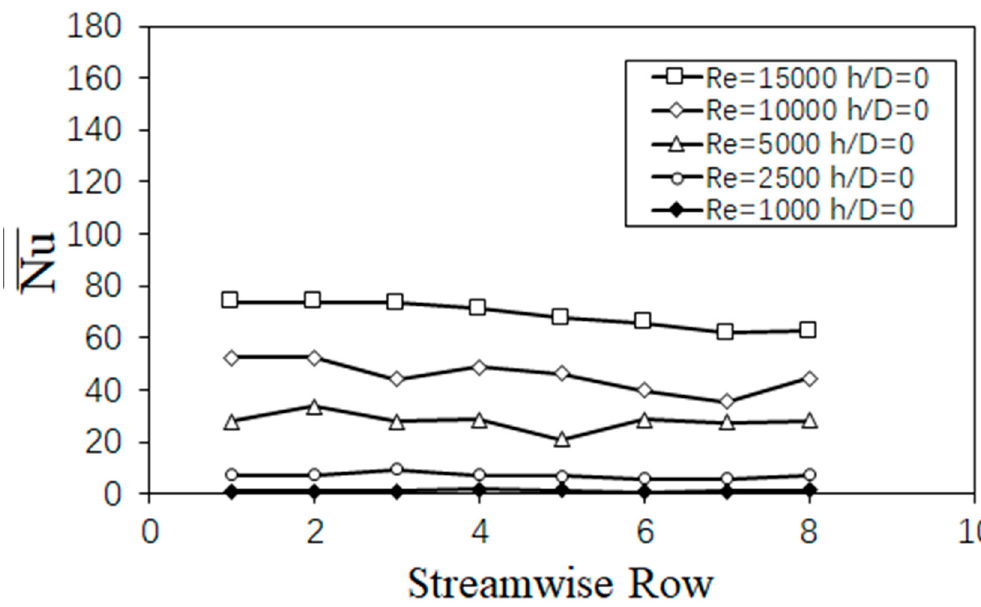
Figure 12. Spatially averaged Nusselt numbers as dependent upon streamwise row location, for different Re j , for smooth surface target plate.